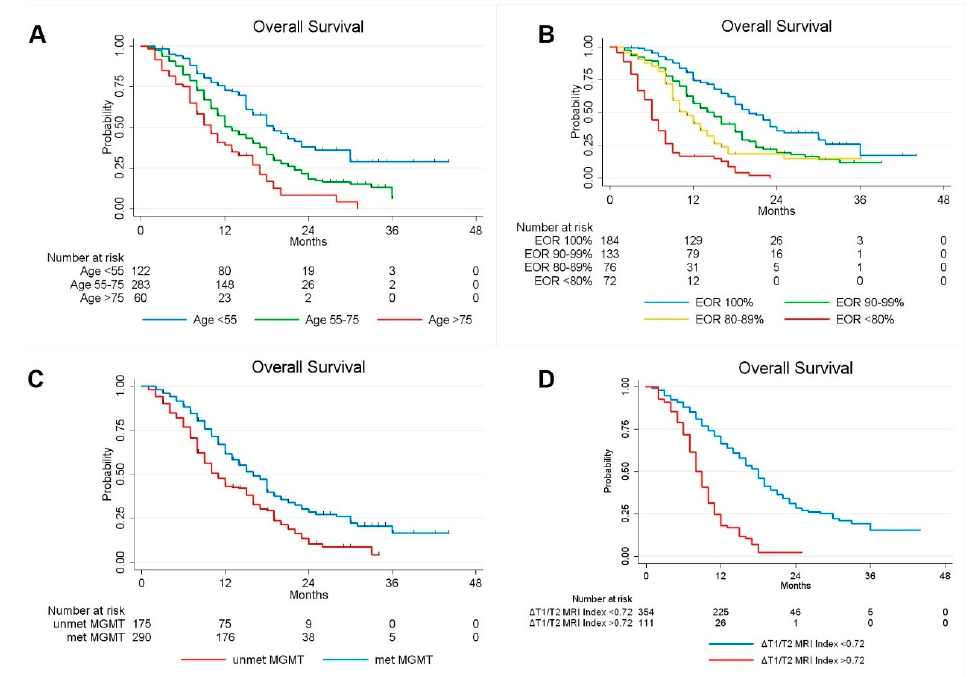
Figure 2. Kaplan-Meier curves displaying OS of GBM patients according to Age ( A ); EOR ( B ); MGMT promoter methylation status( C ); and preoperative Δ T1/T2 MRI Index ( D ).